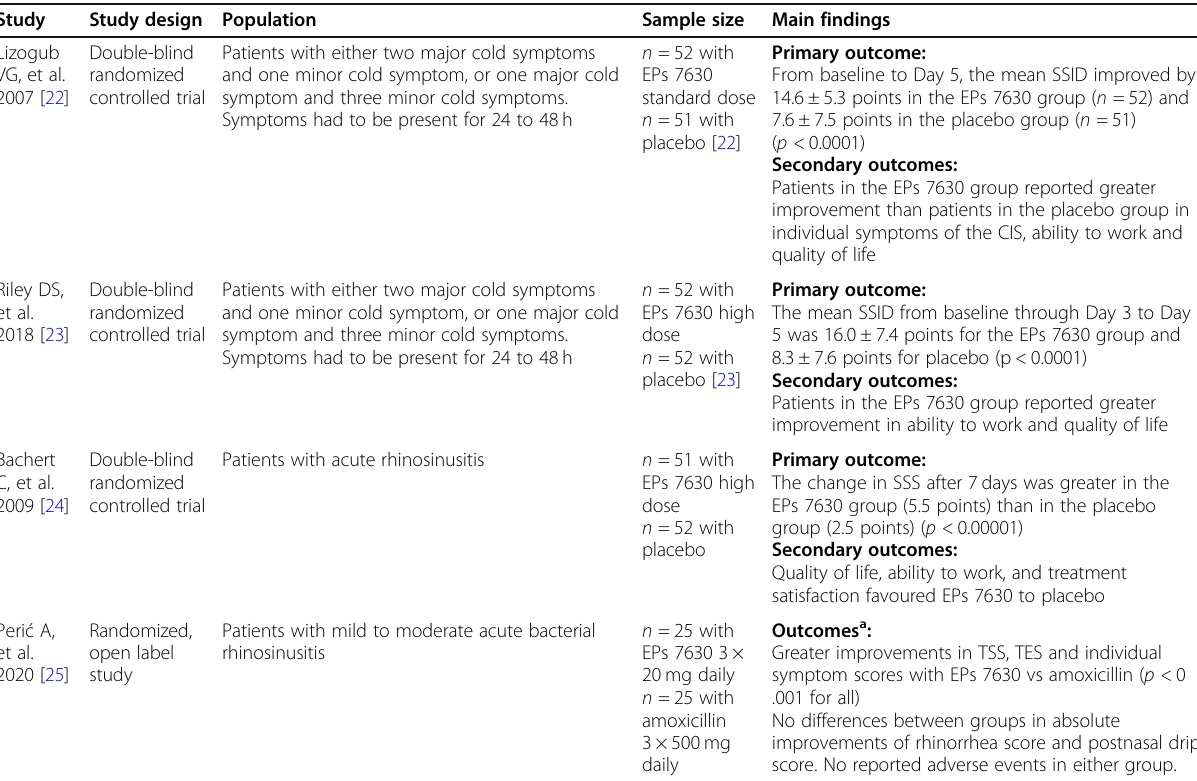
Table 2 Clinical studies of Pelargonium sidoides extract (EPs 7630) Study Study design